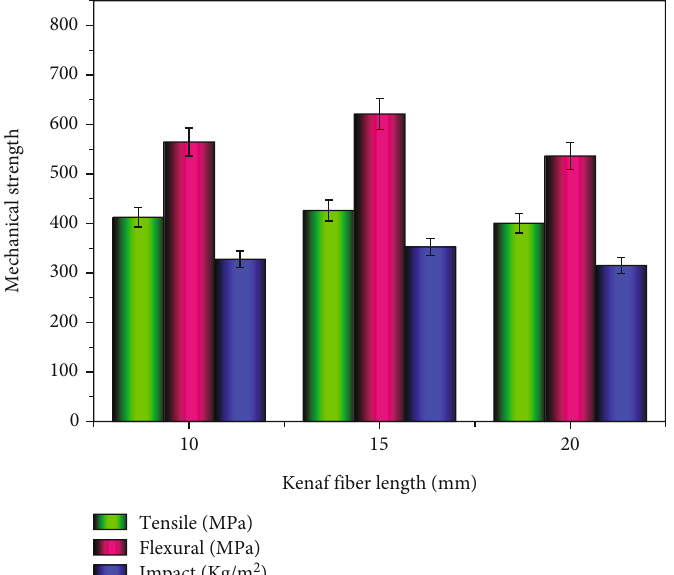
Figure 3: Mechanical properties of nanocomposites based on kenaf fi ber length: (a) tensile strength; (b) fl exural strength; (c) impact